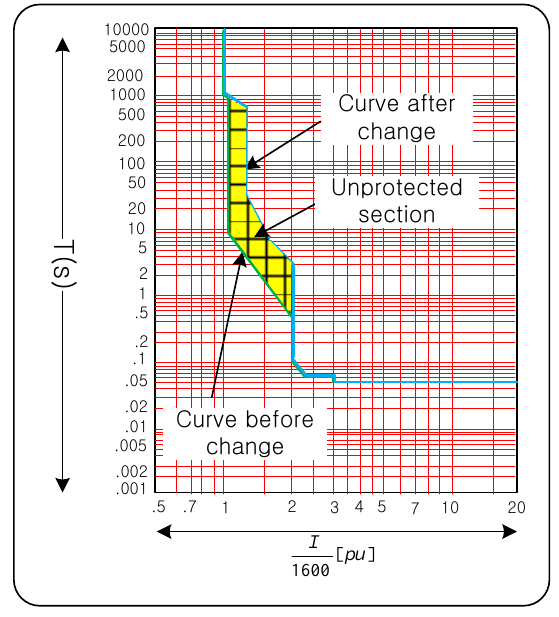
Figure 6. Actual OCR curves after and before re-coordination.